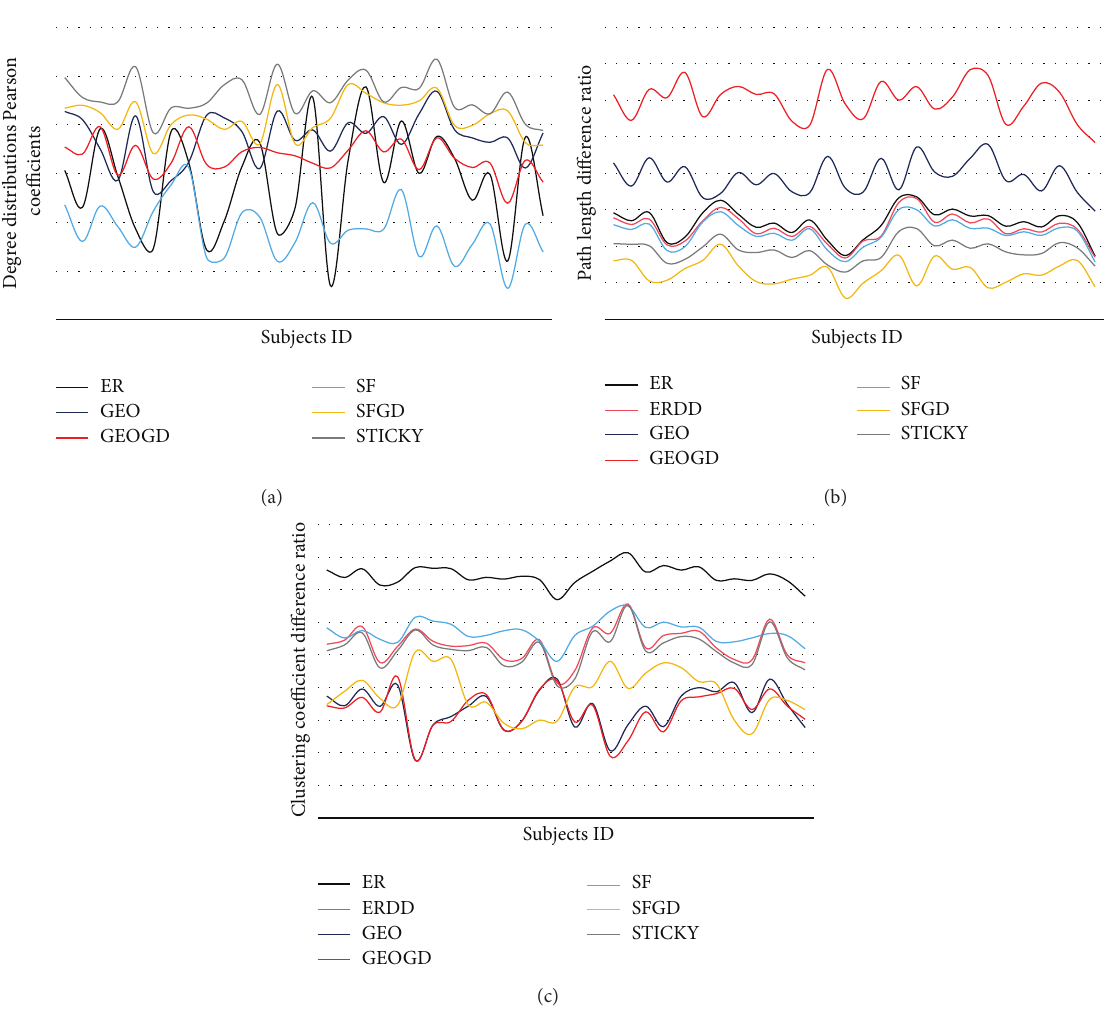
Figure 2: The global graph properties of 7 network models compared with real brain networks (28 subjects). (a) The Pearson correlation coefficients between the degree distributions. Higher value means the graph model can describe the real brain network better. (b) Average shortest path length difference ratio. (c) Average clustering coefficient difference ratio. Lower value means the graph model can describe the real brain network better. The 𝑥 -axis is subject